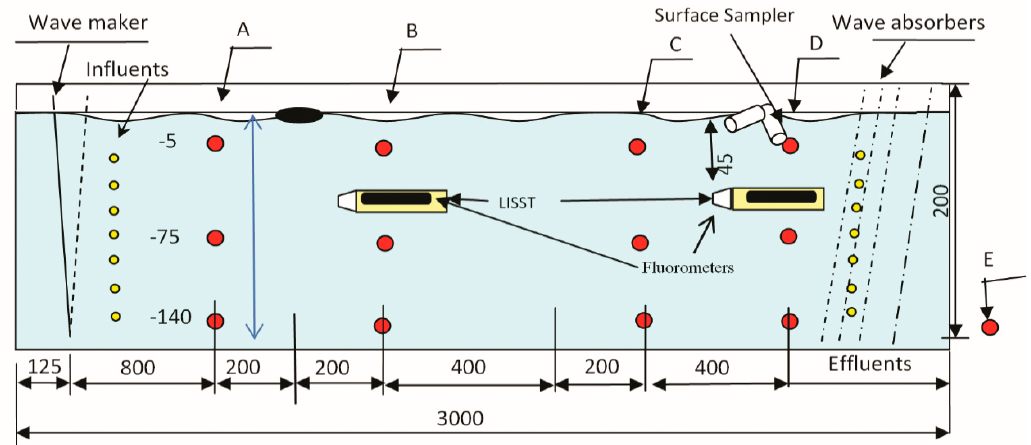
Figure 1. Schematic diagram (not to scale, all units in cm) illustrating the location of the oil source (black ellipse between A and B), Laser In-situ Scattering and Transmissometry (LISST) particle counters, sampling locations at A, B, C, D (3 depths), the effluent port E (1 port) and surface (near sample location D). LISST#1 is at location B (ca. 1.2 m downstream at a 0.45 m depth) and LISST#2 is at location D (ca. 12 m downstream at a 0.45 m depth) of oil release.